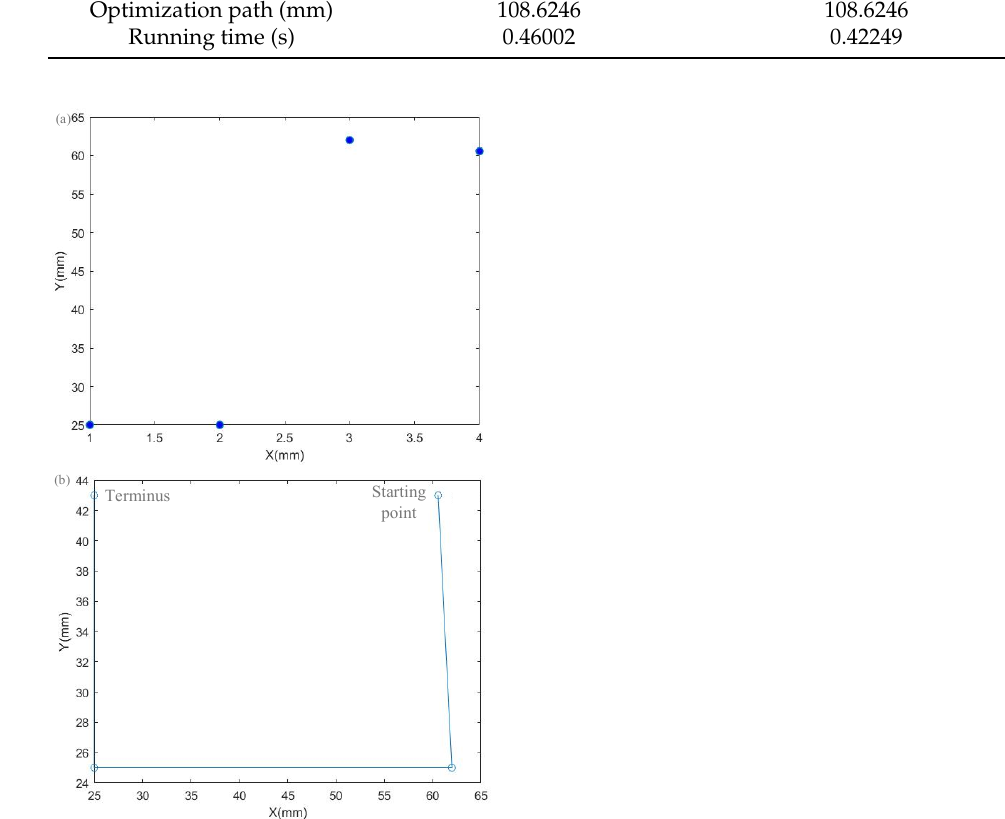
Figure 22. Optimization of the movement path between processing frames. ( a ) Processing frame center point distribution. ( b ) Processing frame center point optimization path.